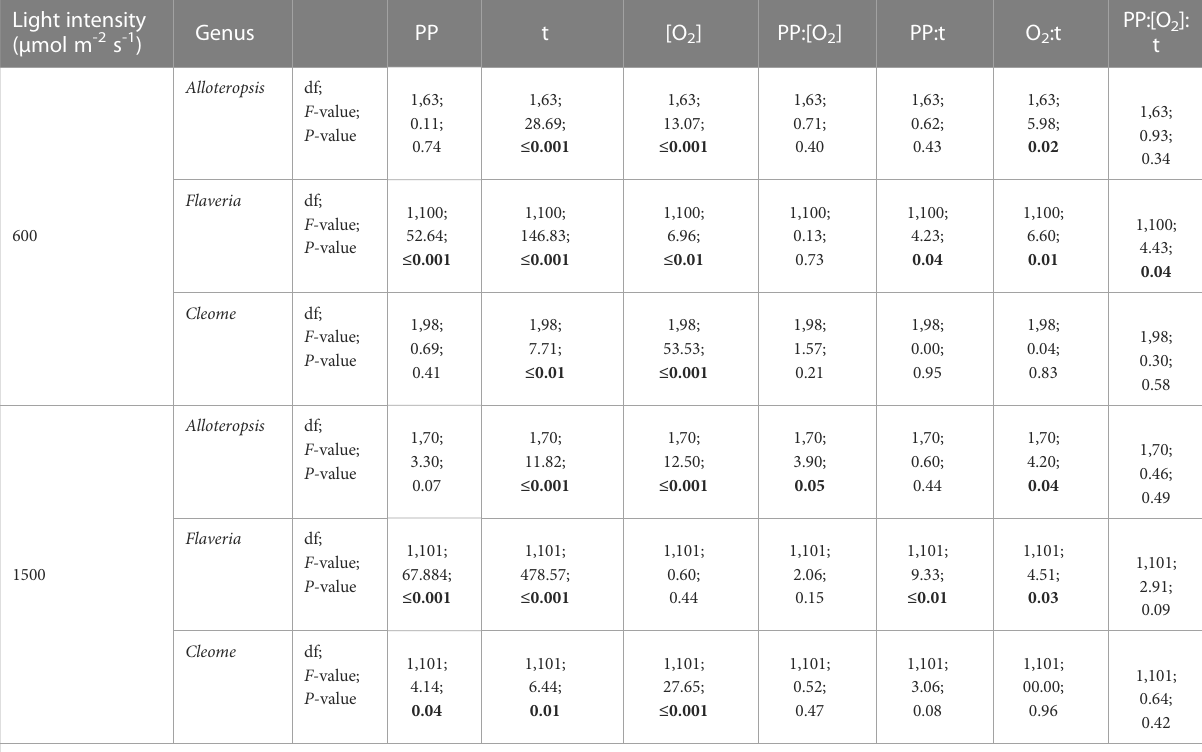
TABLE 4 ANOVA table of the F PSII/ F CO 2 ratio during light induction for phylogenetically linked C 3 and C 4 Alloteropsis , Flaveria and Cleome species. Light